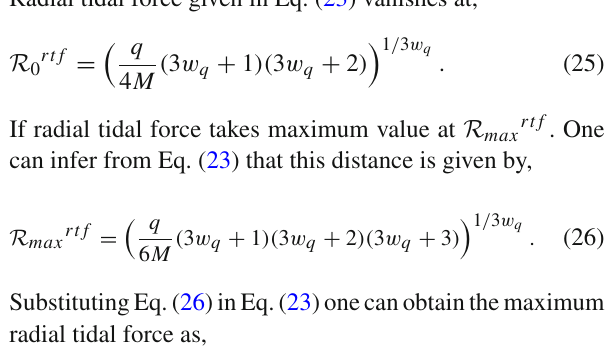
Substituting Eq. (22) into Eq. (20), equations for tidal